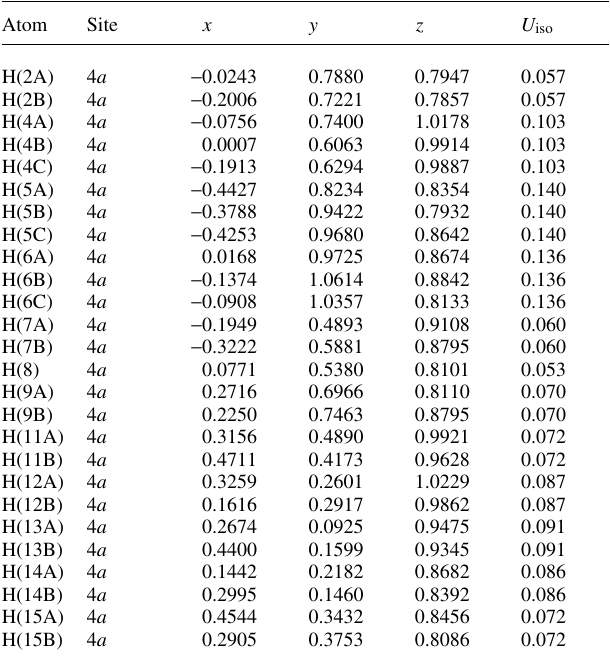
Table 2. Atomic coordinates and displacement parameters (in Å 2 )